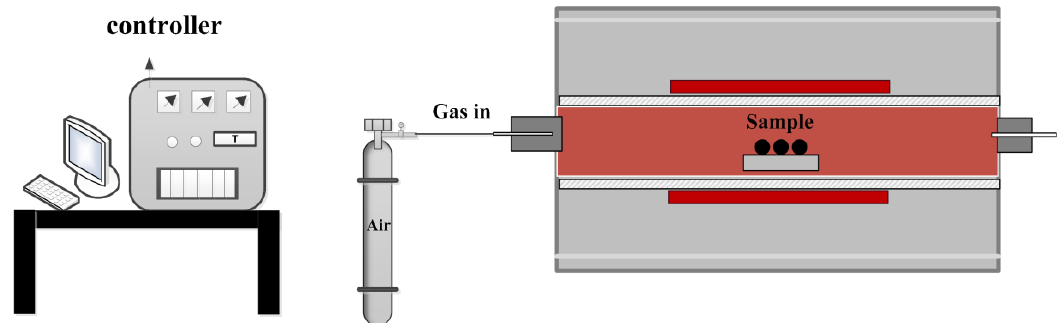
Figure 3. Particle size distribution of milled nickel slag.